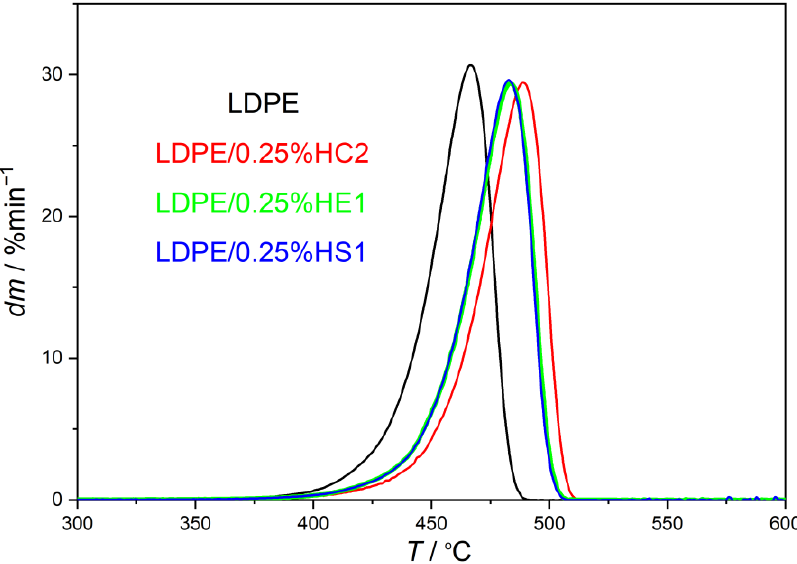
Figure 5. DTG curves of prepared LDPE/hematite composites containing 0.25% hematite particles.